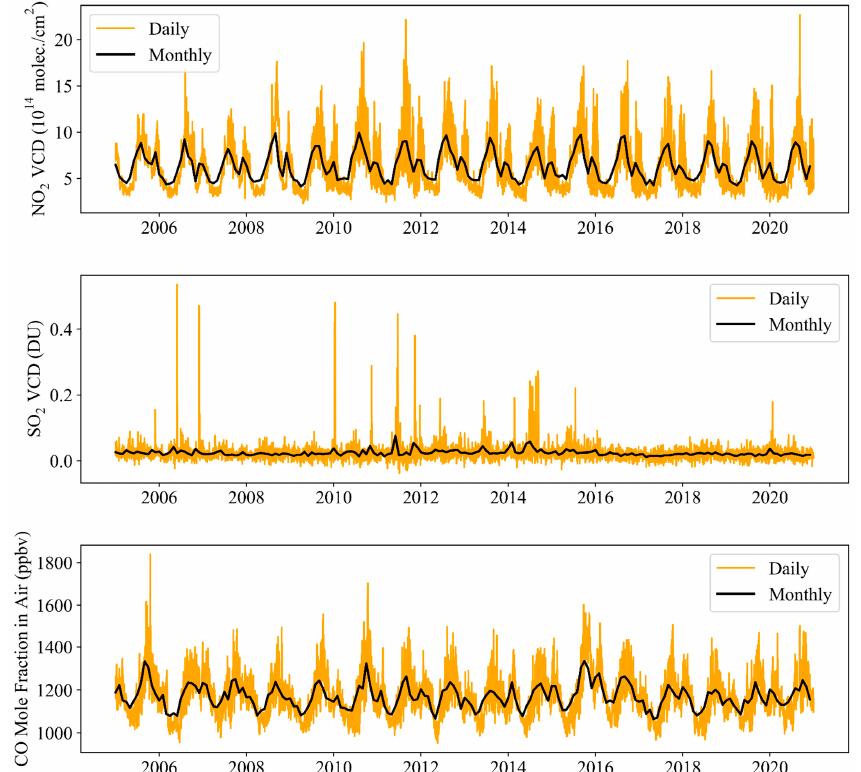
Figure 4. Daily and monthly area averages of NO 2 ( top ), SO 2 ( middle ) and CO ( bottom ) taken over the entire region.